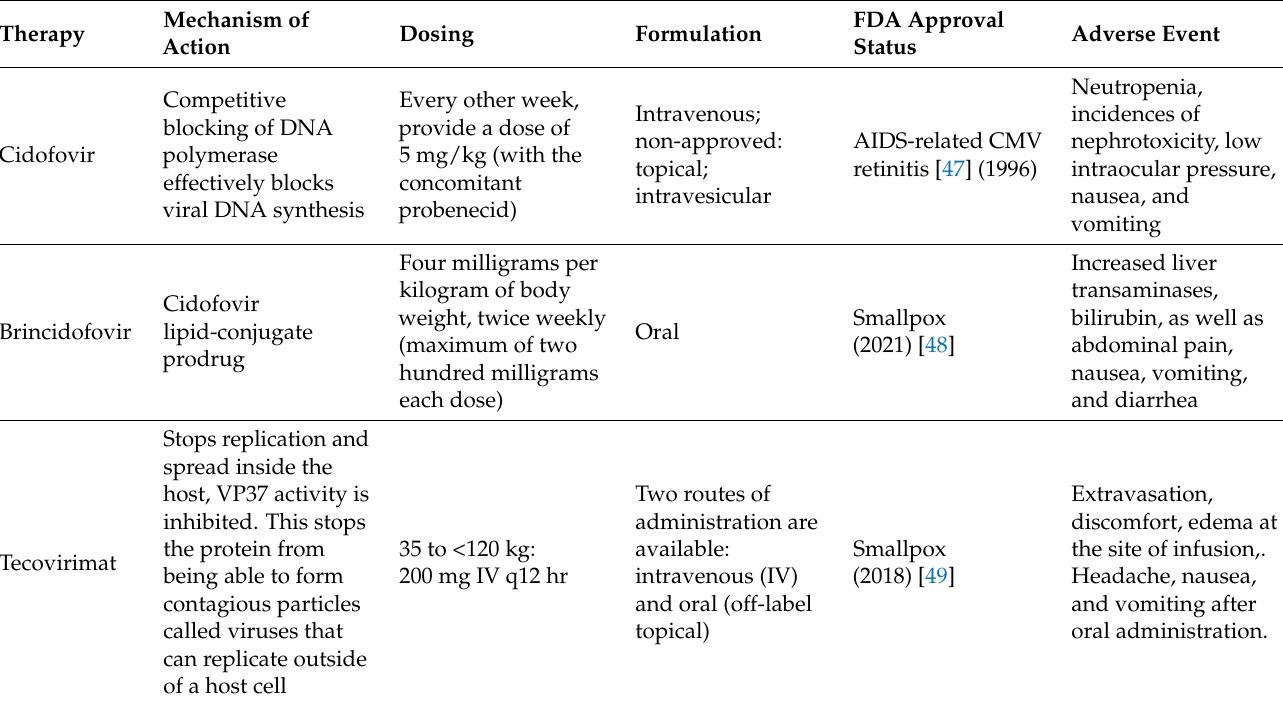
Table 1. Potential therapies for